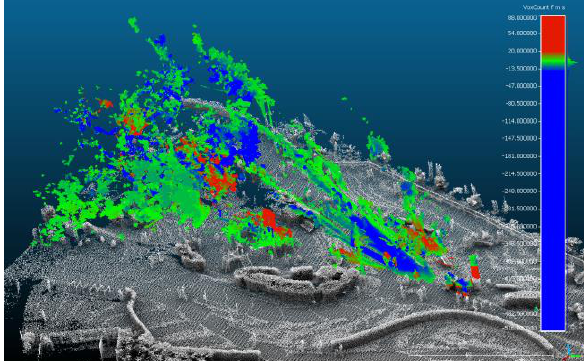
Figure 6. Difference of fixation count for each point, computed as number of fixations of the first walk minus number of fixations of the second walk. Red color indicates that more fixations have occurred during the first walk, while blue color indicates that more fixations occurred during the second walk. Green color illustrates the same level of fixations in both